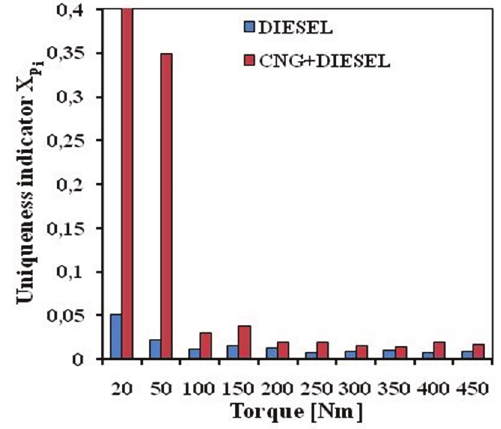
Fig. 14. Comparison of the value of the uniqueness indicator for the partial indicator diagram of the Perkins 1104D-E44TA engine operating accord-